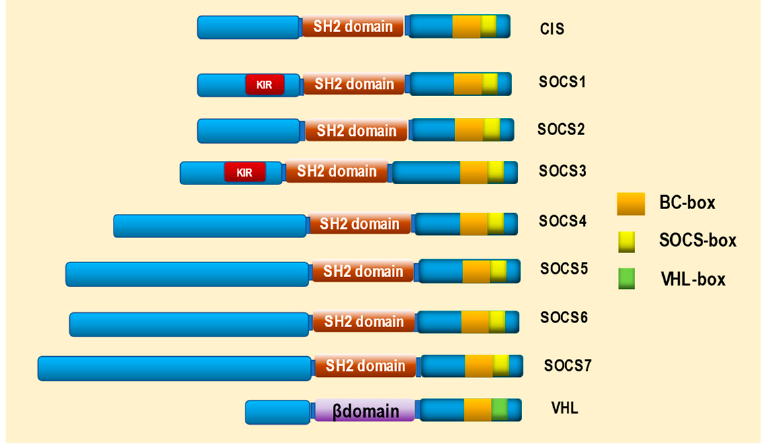
Figure 2. Structure of suppressor of cytokine signaling (SOCS) and von Hippel-Lindau (VHL) proteins. SOCS family proteins, cytokine-inducible Src homology 2 (SH2)-containing protein (CIS), and SOCS1–7 contain an SH2 domain, BC box, and SOCS box. SOCS1 and SOCS3 also contain a kinase inhibitory region (KIR). VHL contains a β domain, BC box, and VHL box.